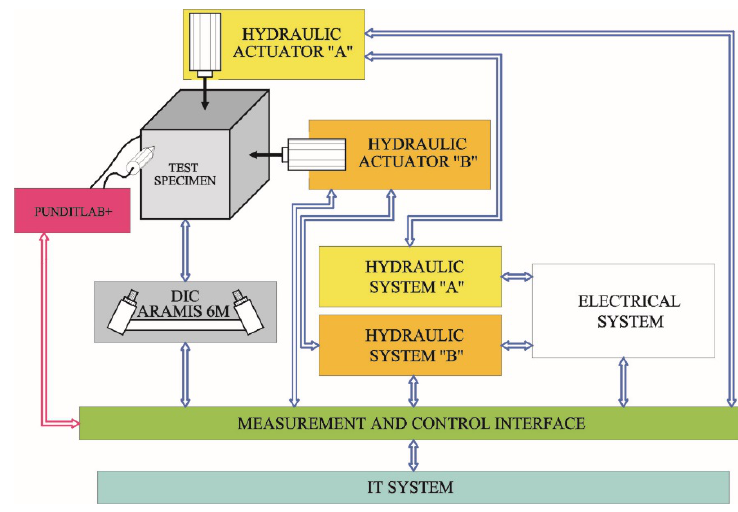
Figure 3. Block diagram of the test